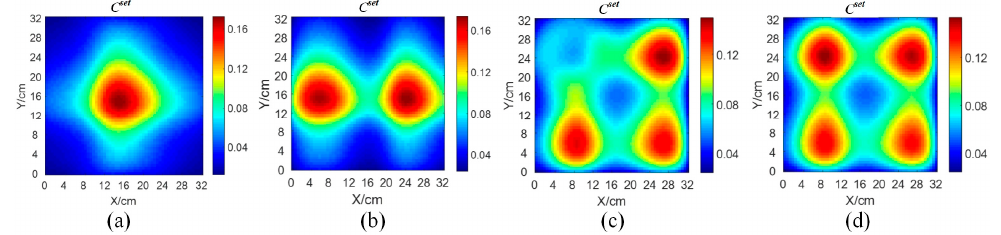
Figure 3. Four different distributions of H 2 O concentration in the simulation. ( a ) One flame, ( b ) Two flames, ( c ) Three flames, and ( d ) Four flames.